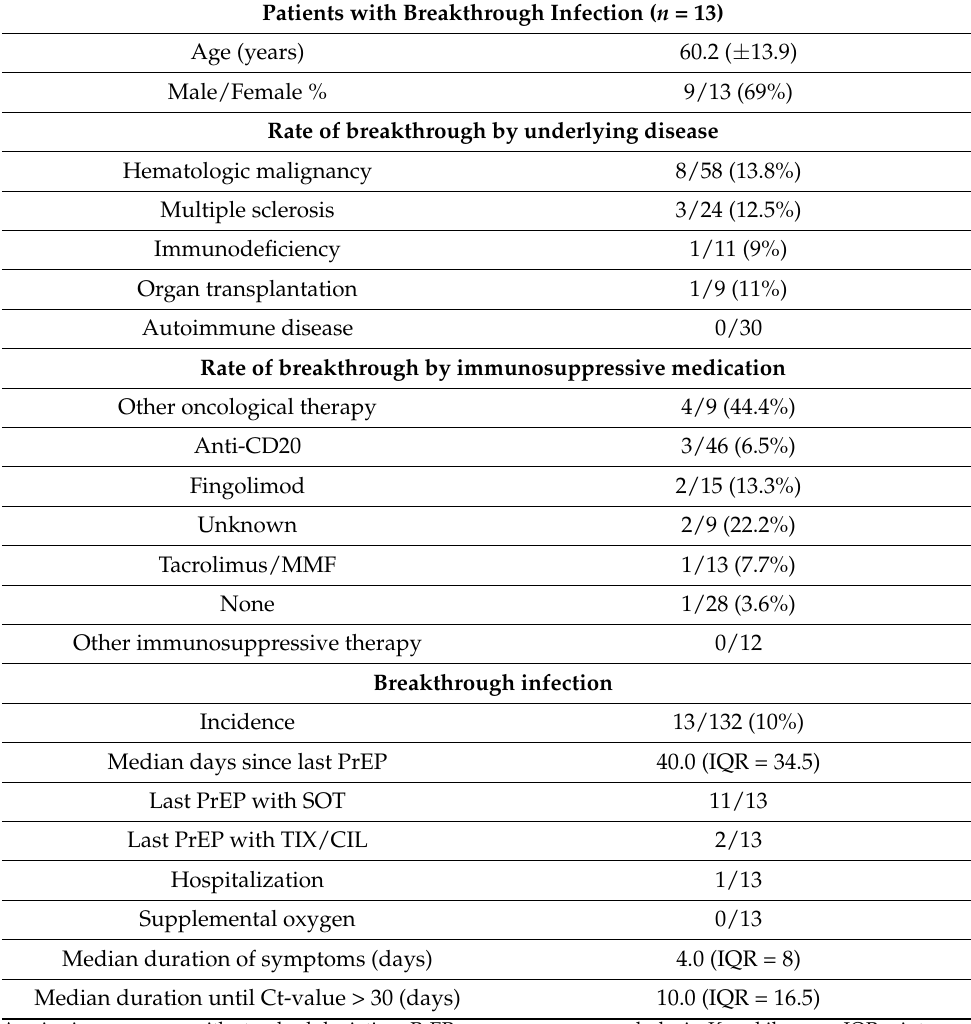
Table 2. Characteristics of patients with breakthrough